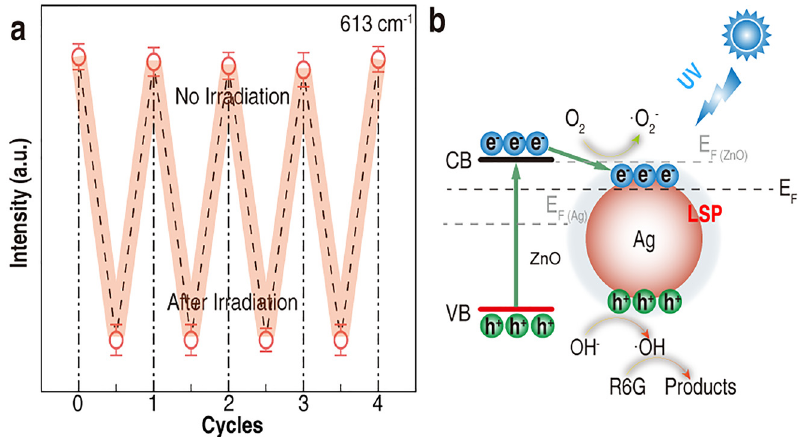
Figure 5: (a) Cyclic Raman test of hydrophilic